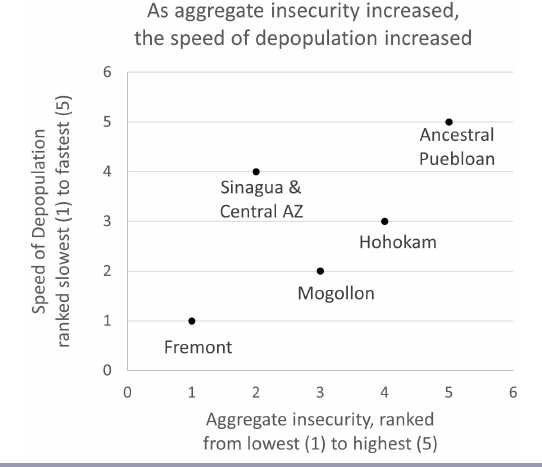
Fig. 9 . Relationship between aggregated insecurity and the speed of depopulation by culture areas. Spearman’s Rho is 0.7, p = 0.19. The low p-value can be explained in part by the small sample